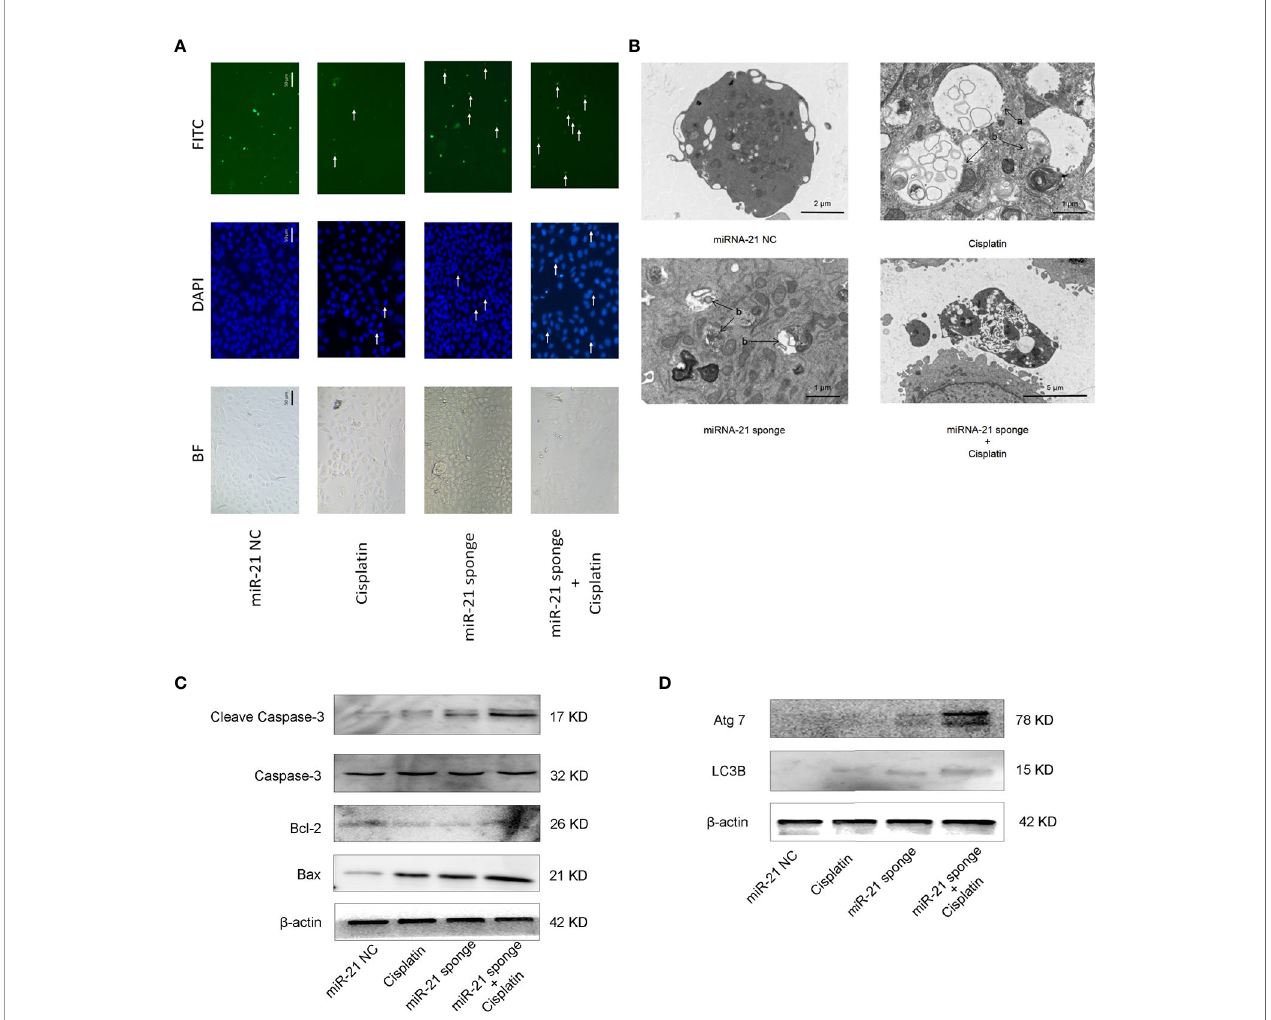
FIGURE 6 | miRNA-21 combinedwith cisplatin promotes celldeath in A549/DDPcells. (A) The effects of miRNA-21 combined with cisplatin on autophagyand apoptosis of A549/DDPcellswere observed under a commonmicroscope anda fl uorescence microscope. In the DAPI fi eld ofvision,the white arrow marks the nuclear fragments duringapoptosis. In the FITC fi eld of vision,the white arrow marks the autophagosome (B) The effects ofmiRNA-21, combined with cisplatin, onautophagy,apoptosis, and the necrosis of A549/DDPcellswere observed bytransmission electron microscopy. In Figure (B) , a: autophagosome and b:autophagosome. Western blot was used to detect (C) the expression of autophagyand (D) the expression ofapoptosis-relatedproteins inA549/DDPcells induced by miRNA-21, combined with